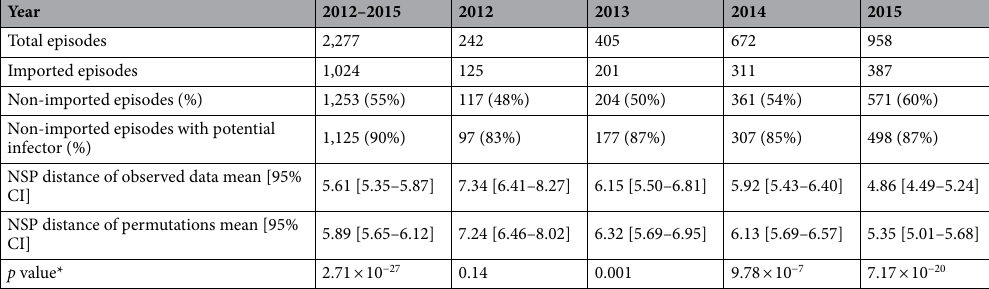
Table 1. Characteristics of 2,277 CPE episodes in France from 2012 to 2015. Potential infectors were identified for a total of 1,125 episodes over the entire 2012 to 2015 period. In year-specific analyses, CPE data only contained episodes occurring from January 1st to December 31st; therefore, the search for potential infectors was restricted to this period. As a result, 128 potential infectors identified in the global analysis were not included in the stratified analyses. NSP network-supported path. *Wilcoxon paired rank sum test p value comparing NSP distances between observed and permuted